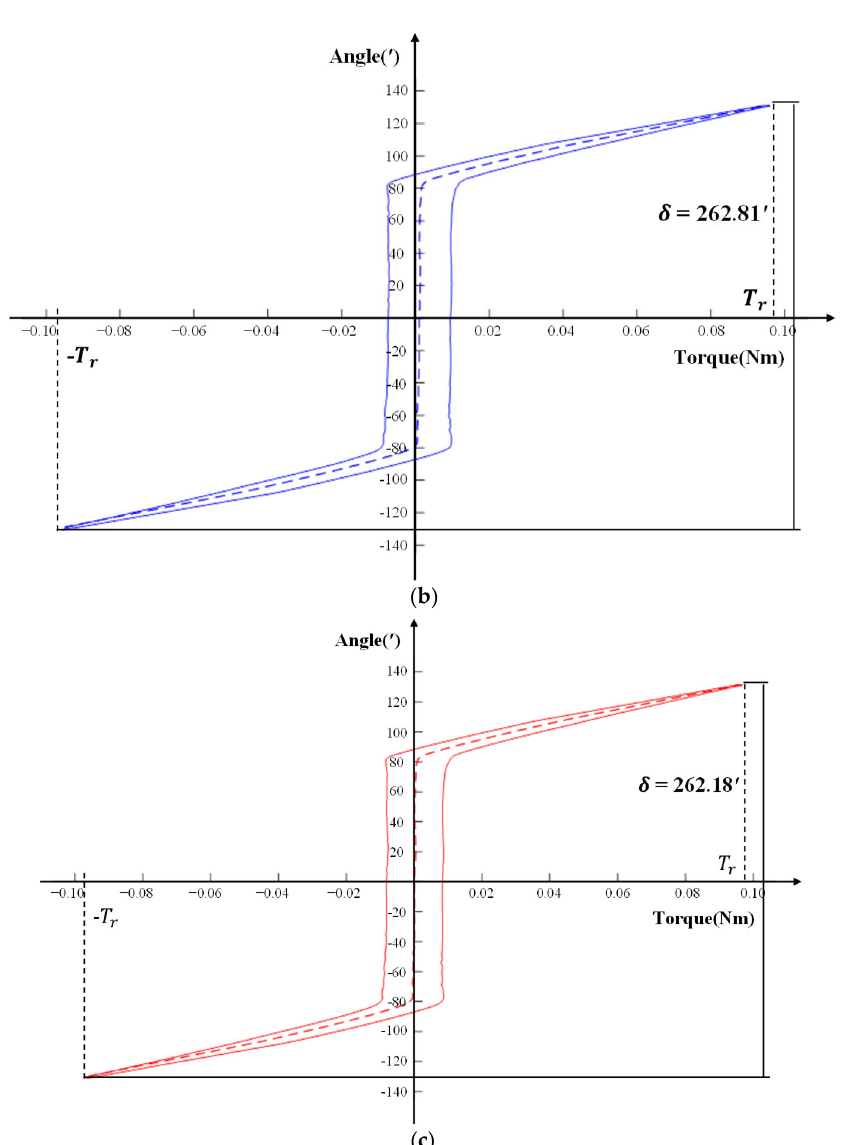
Figure 17. Hysteresis curve of reducer 2 during the first test at three positions of 0 ◦ , 180 ◦ and 360 ◦ . ( a ) 0.01 Nm/s and 0 ◦ ; ( b ) 0.05N m/s and 180 ◦ ; ( c ) 0.1N m/s and 360 ◦ . Table 7. Experiment results of 𝛿 .